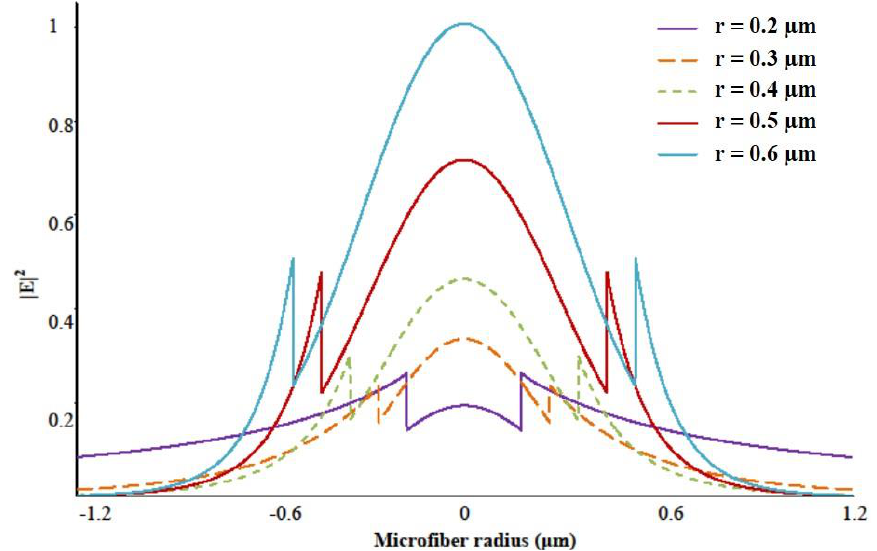
Figure 6. Mode field intensity profile for the HE 11 mode at various MF radii r . The field discontinuity is presented as spikes at the silica-air interface.